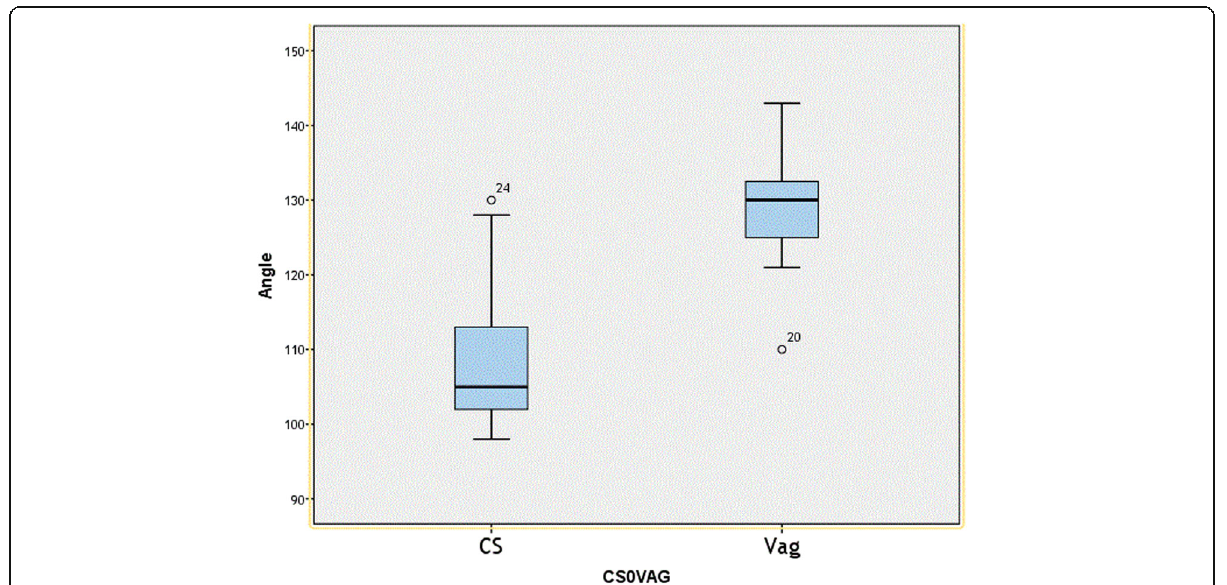
Fig. 4 Box blot diagram showing minimum, maximum values, median, and 25th and 75th percentiles of the mode of delivery and the angle of fetal head descent